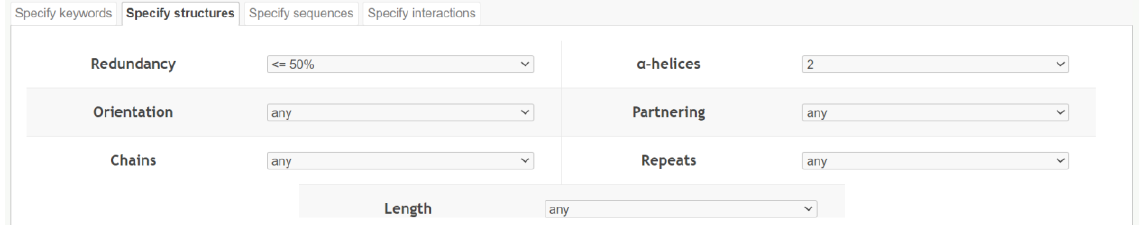
Figure 8. Input parameters for the CC+ dynamic search interface. Retrieval of any non-redundant dimeric coiled coils.